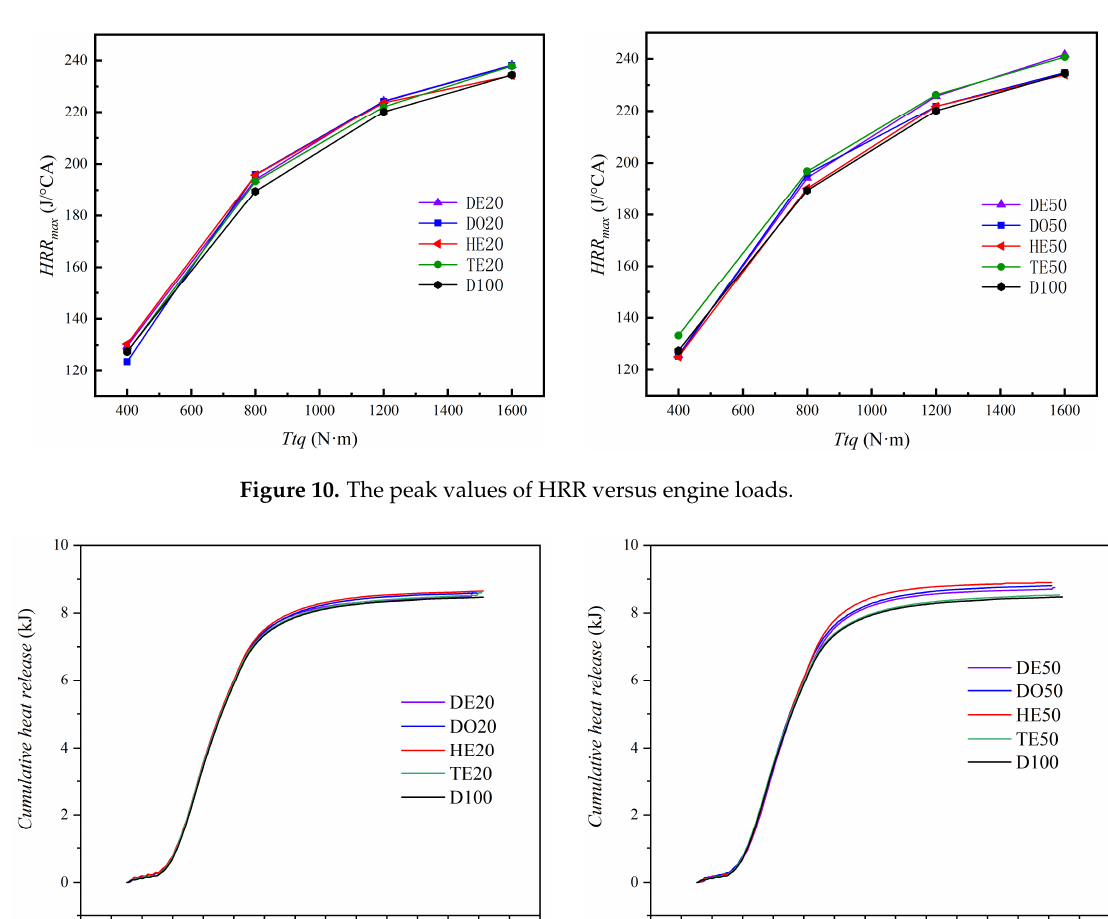
Figure 9. The peak values of in-cylinder pressure versus engine loads.